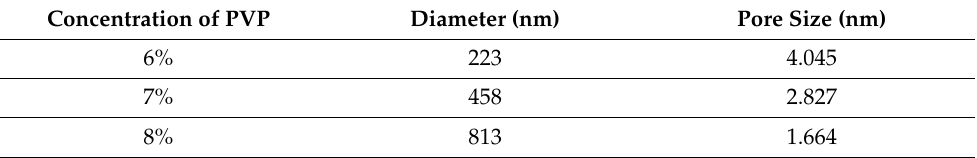
Table 3. Diameter and Pore Size Analysis of as prepared PVP/TiO 2 nanofibers by SEM. Concentration of